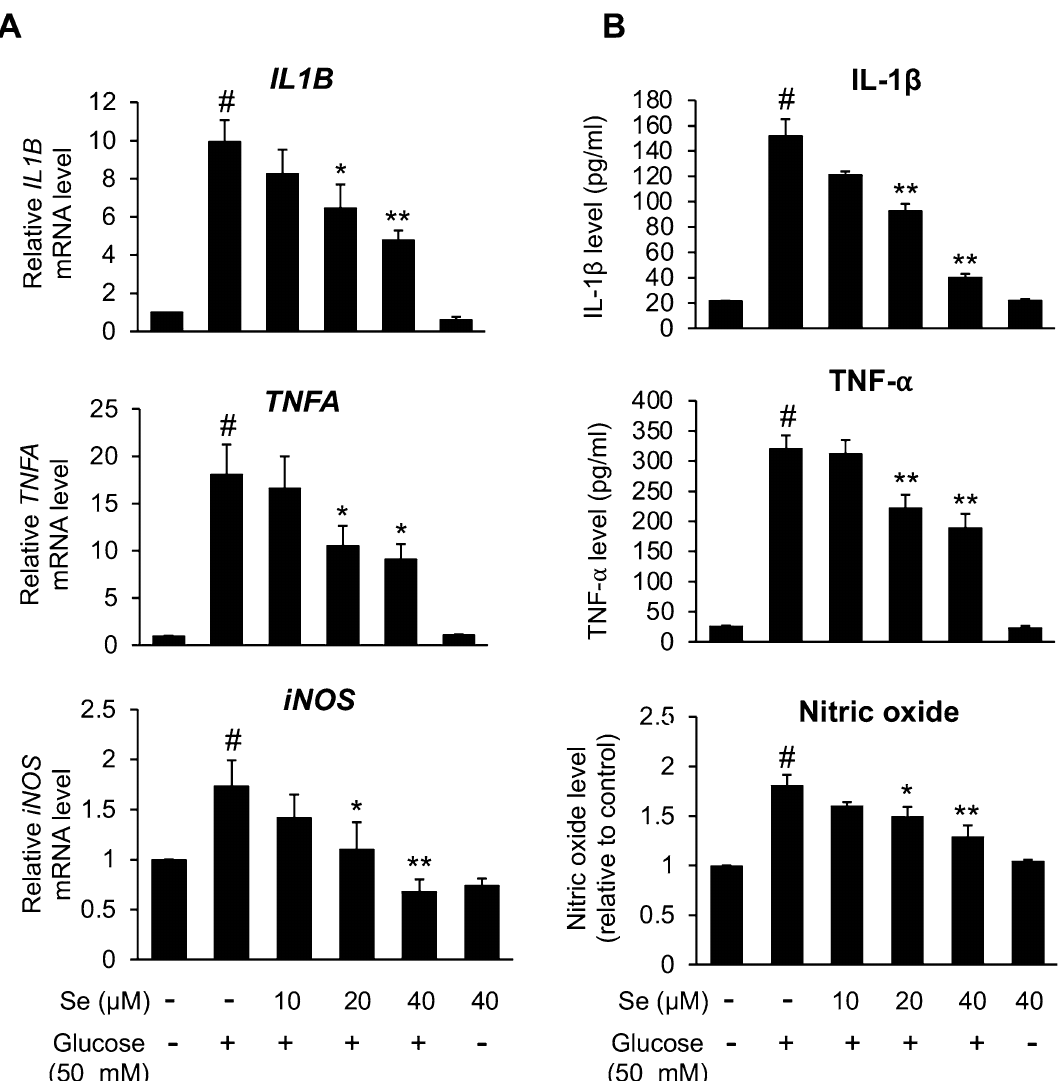
Figure 5. Effects of sesamin on inflammatory gene expression ( A ) and secretion of inflammatory mediators ( B ) in high glucose-activated BV2 cells. The pretreatment of BV2 cells with sesamin (10, 20, 40 μM) for 4 h was performed before BV2 cells were treated with 50 mM of glucose. Following the incubation for 24 or 48 h, the gene expression ( IL1B , TNFA , iNOS ) and the secretion of inflammatory mediators (IL-1β, TNF- ⍺ , NO) were tested by real-time PCR and ELISA, other than NO that was studied by Griess’s assay. The outcomes are shown as the means ± SEM from three individual experiments. # P < 0.05 versus the control group and * P < 0.05 or ** P < 0.01 versus the glucose-treated